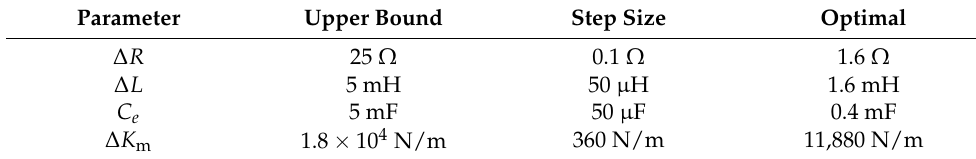
Table 4. Parameter upper bounds and step size settings.